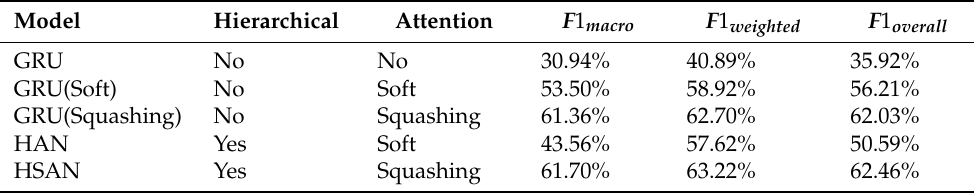
Table 7. Evaluation of the hierarchical and nonhierarchical structures.